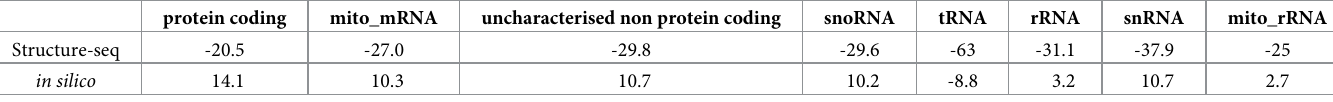
(MFEden [59]) of all folded structures: P . falciparum had a significantly higher MFEden than P . knowlesi (respectively 14.03 and 7.1, t-test p -value < 0.0001). Secondly, we looked at the occurrence of various structures by comparing the length-normalised number of nucleotides participating in a structure (e.g. a hairpin or bulge) in each P . falciparum transcript with their P . knowlesi orthologs. The structurome of P . falciparum had significantly more nucleotides involved in hairpins and multi-stem loops than the structurome of P . knowlesi (t-test, p -value < 0.0001), whereas P . knowlesi had significantly more nucleotides involved in stems and bulges (t-test, p -value < 0.0001) (S5 Table). Table 3. MFEden average for every type of RNA molecule. protein coding